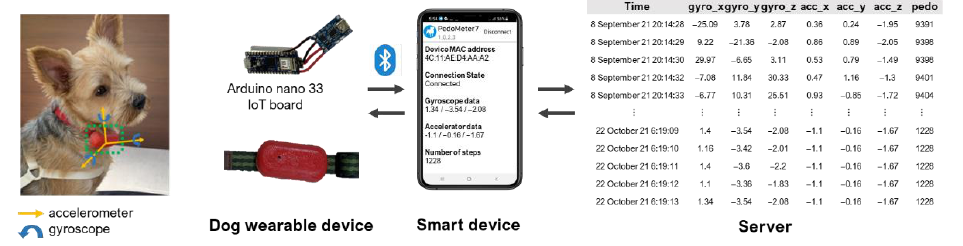
Figure 4. The process of collecting sensor data from a manufactured wearable device.